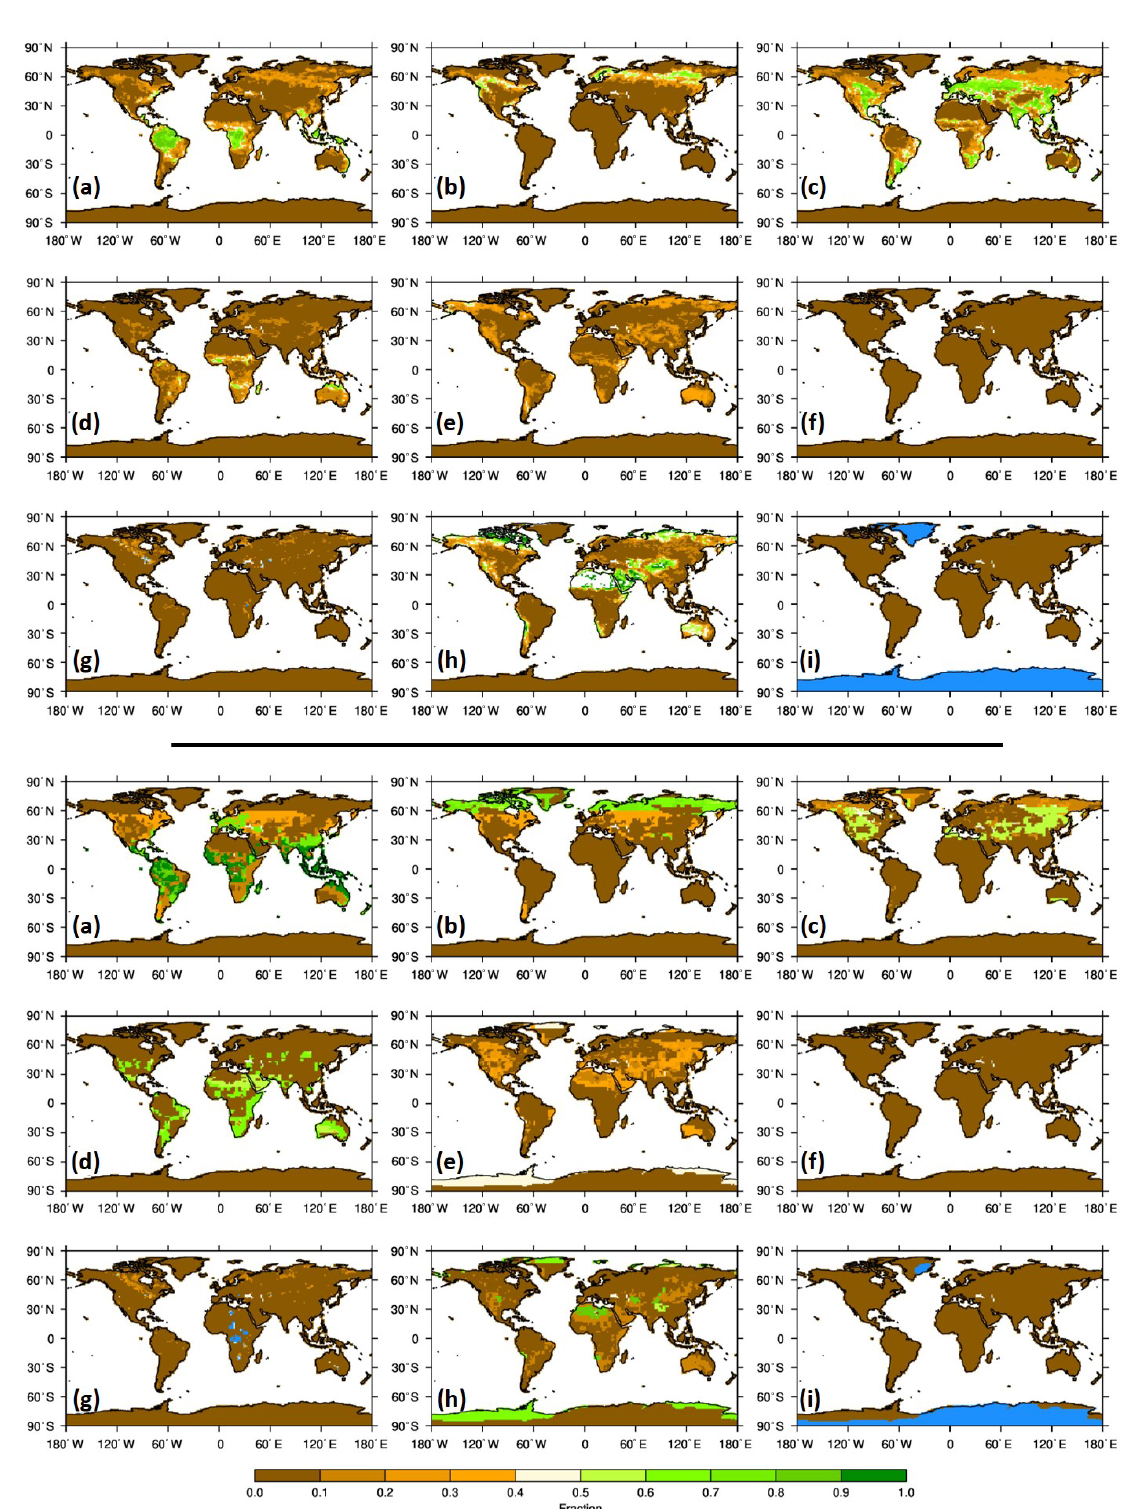
Figure 3. The nine PFTs used in HadGEM3. The top half of the figure (the first set of labelled panels) shows the piControl simulation, and the bottom half shows the mPWP simulation. Values in brackets show global mean differences ( mPWP − piControl ), expressed as a percentage: (a) broadleaf trees (18%), (b) needle-leaved trees (5%), (c) temperate C 3 grass ( − 15%), (d) tropical C 4 grass (6%), (e) shrubs (3%), (f) urban areas (no change), (g) inland water (1%), (h) bare soil ( − 12%), and (i) land ice ( − 5%).